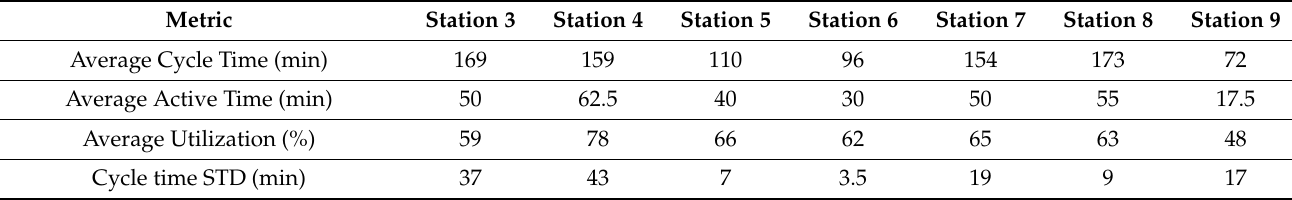
Table 4. Progress monitoring report using the proposed progress monitoring method.